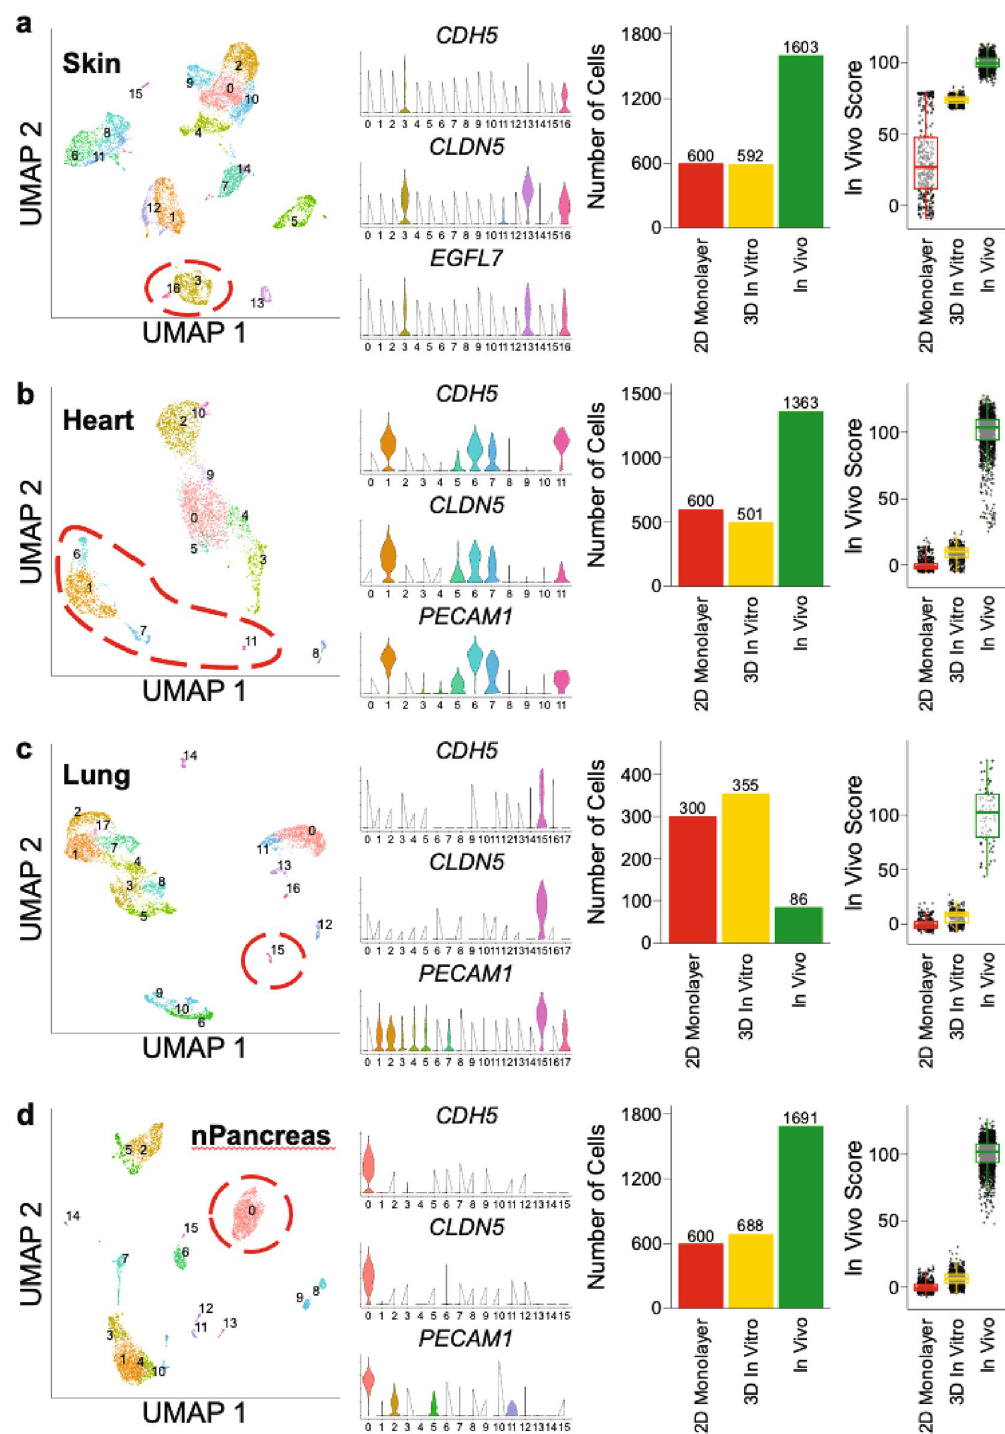
Figure 6. Transcriptomes of 3D in vitro ECs are more similar to in vivo ECs compared to 2D monolayer. ( a ) Comparison of ECFC-EC 2D in vitro monolayer, Heart 3D in vitro microvessel network ECs, and publicly available Heart in vivo ECs. Clustering determined using Seurat, and EC clusters identified using EC characteristic genes CDH5 , CLDN5 , and PECAM1 . In Vivo Score determined by DEGs defining Heart in vivo ECs. * p < 0.05 by One-Way ANOVA. ( b ) Comparison of ECFC-EC 2D in vitro monolayer, Skin 3D in vitro microvessel network ECs, and publicly available Skin in vivo ECs. Clustering determined using Seurat, and EC clusters identified using EC characteristic genes CDH5 , CLDN5 , and EGFL7 . In Vivo Score determined by DEGs defining Skin in vivo ECs. * p < 0.05 by One-Way ANOVA. ( c ) Comparison of ECFC-EC 2D in vitro monolayer, Lung 3D in vitro microvessel network ECs, and publicly available Lung in vivo ECs. Clustering determined using Seurat, and EC clusters identified using EC characteristic genes CDH5 , CLDN5 , and PECAM1 . In Vivo Score determined by DEGs defining Heart in vivo ECs. * p < 0.05 by One-Way ANOVA. ( d ) Comparison of ECFC-EC 2D in vitro monolayer, nPancreas 3D in vitro microvessel network ECs, and publicly available nPancreas in vivo ECs. Clustering determined using Seurat, and EC clusters identified using EC characteristic genes CDH5 , CLDN5 , and PECAM1 . In Vivo Score determined by DEGs defining nPancreas in vivo ECs. * p < 0.05 by One-Way